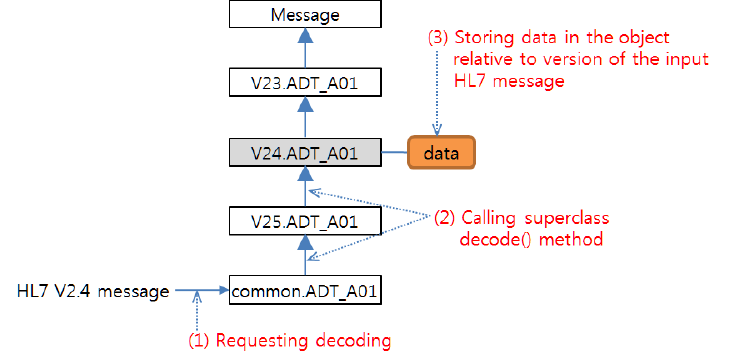
Fig. 5. Decoding procedure of an HL7 message.